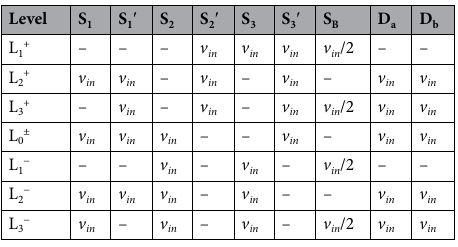
Table 1. Voltage stress on switches.